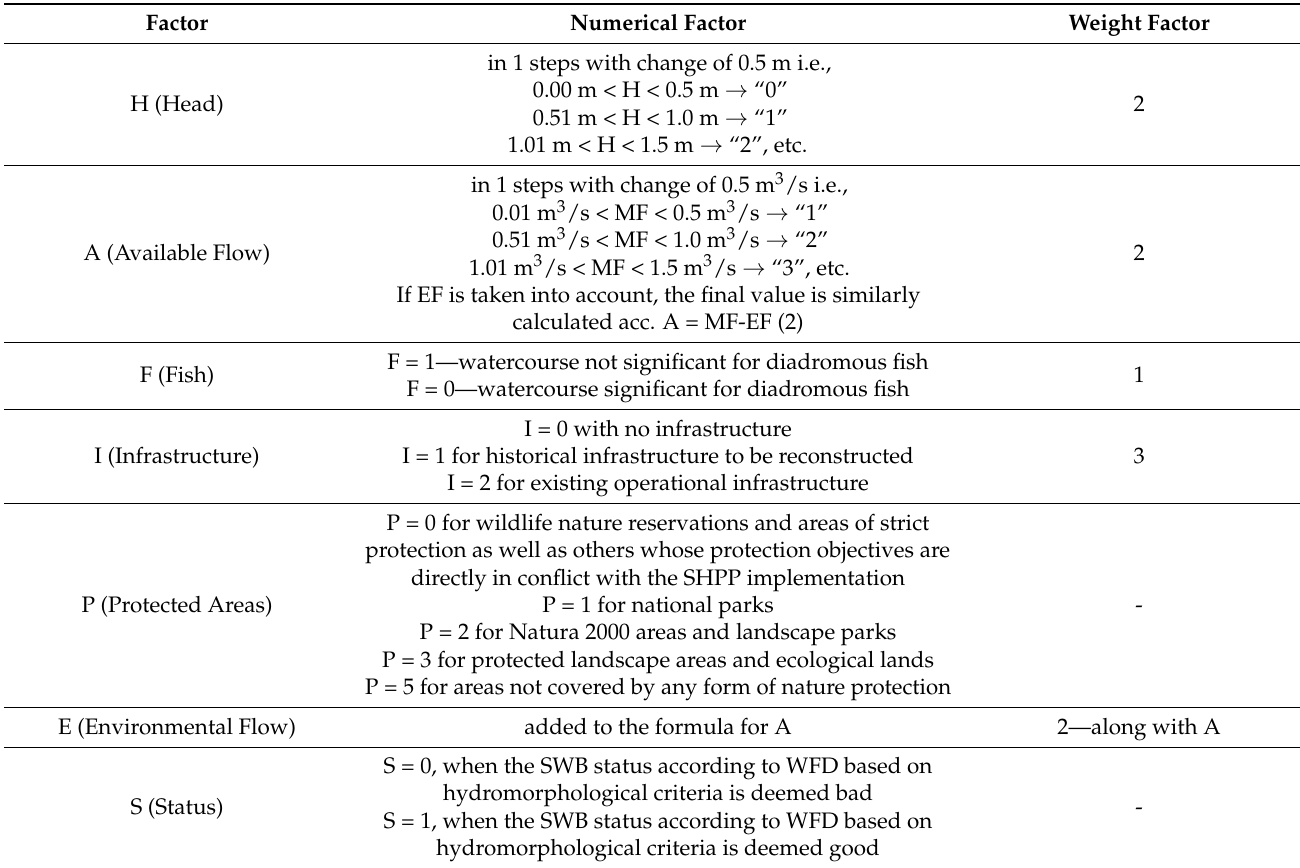
Table 2. Characteristics of factors in the HAFIPES system.